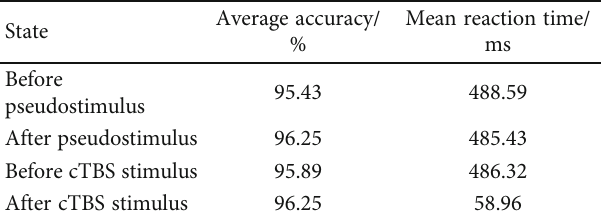
Table 3: Parameter analysis of fi nger button motion